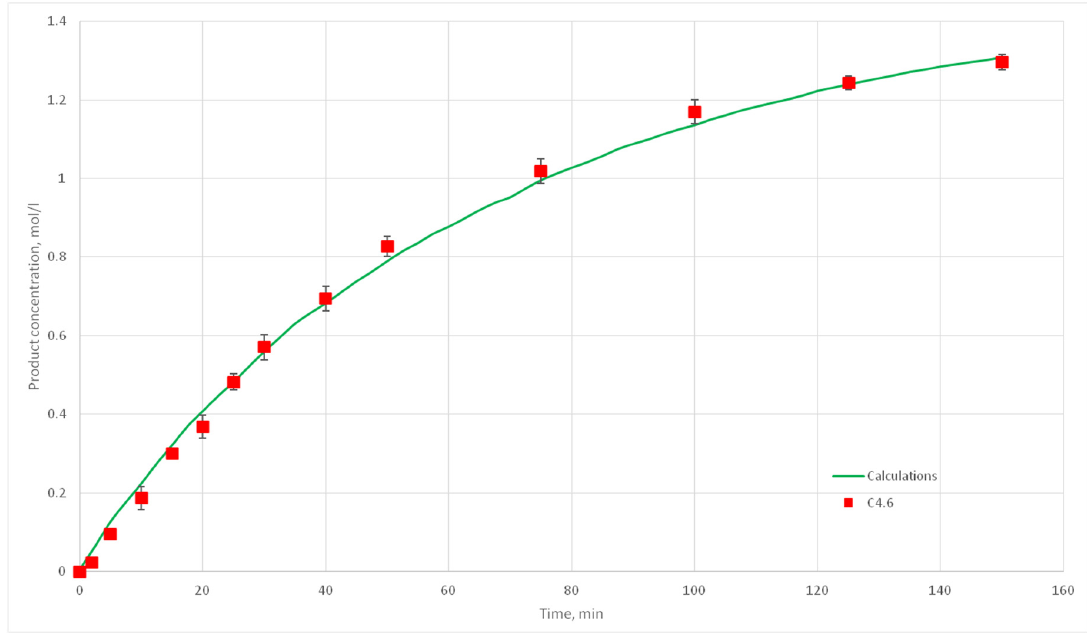
Figure 24. Calculation and experimental reaction kinetic curves for С 4.6 experiment.